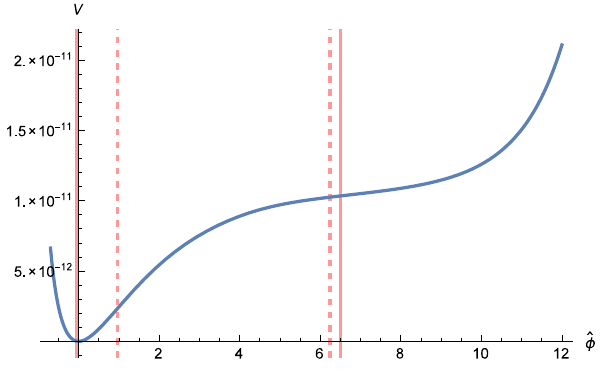
Figure 1 . Plot of the inflationary potential for the example set (4.12). The red vertical lines correspond to the walls of the K¨ahler cone while the dashed vertical lines denote horizon exit and the end of inflation where ǫ =